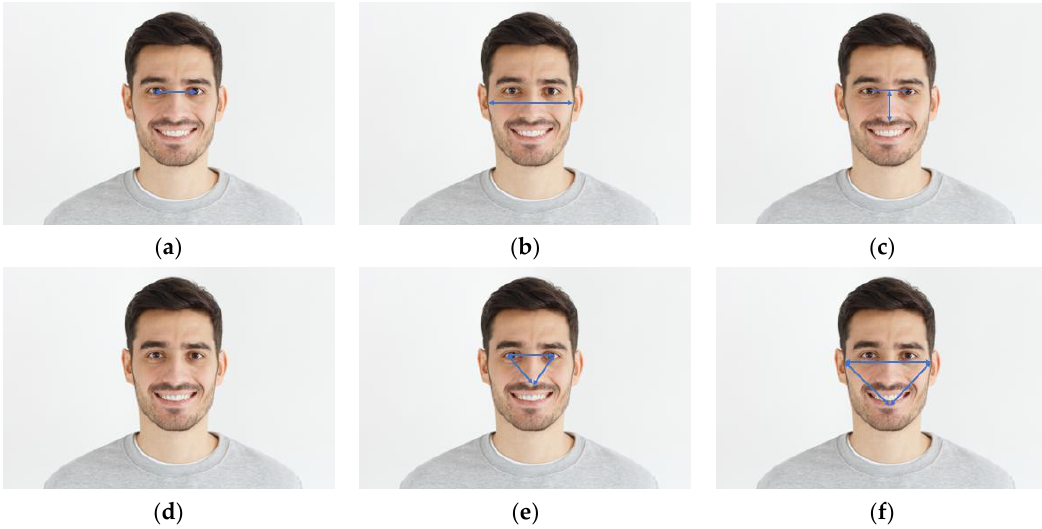
Figure 5. Selected features by Banerrjee [15]. ( a ) distance between eyes, ( b ) distance between ears, ( c ) distance between the nose and forehead, ( d ) width of the leap, in addition to the following angles where the sum is 180°; ( e ) angles between eyes and nose, ( f ) angles between ears and mouth. The following were used to measure the distance between the face objects: Euclidian distance (EU), city block metric, Minkowski distance, Chebyshev distance and cosine distance.